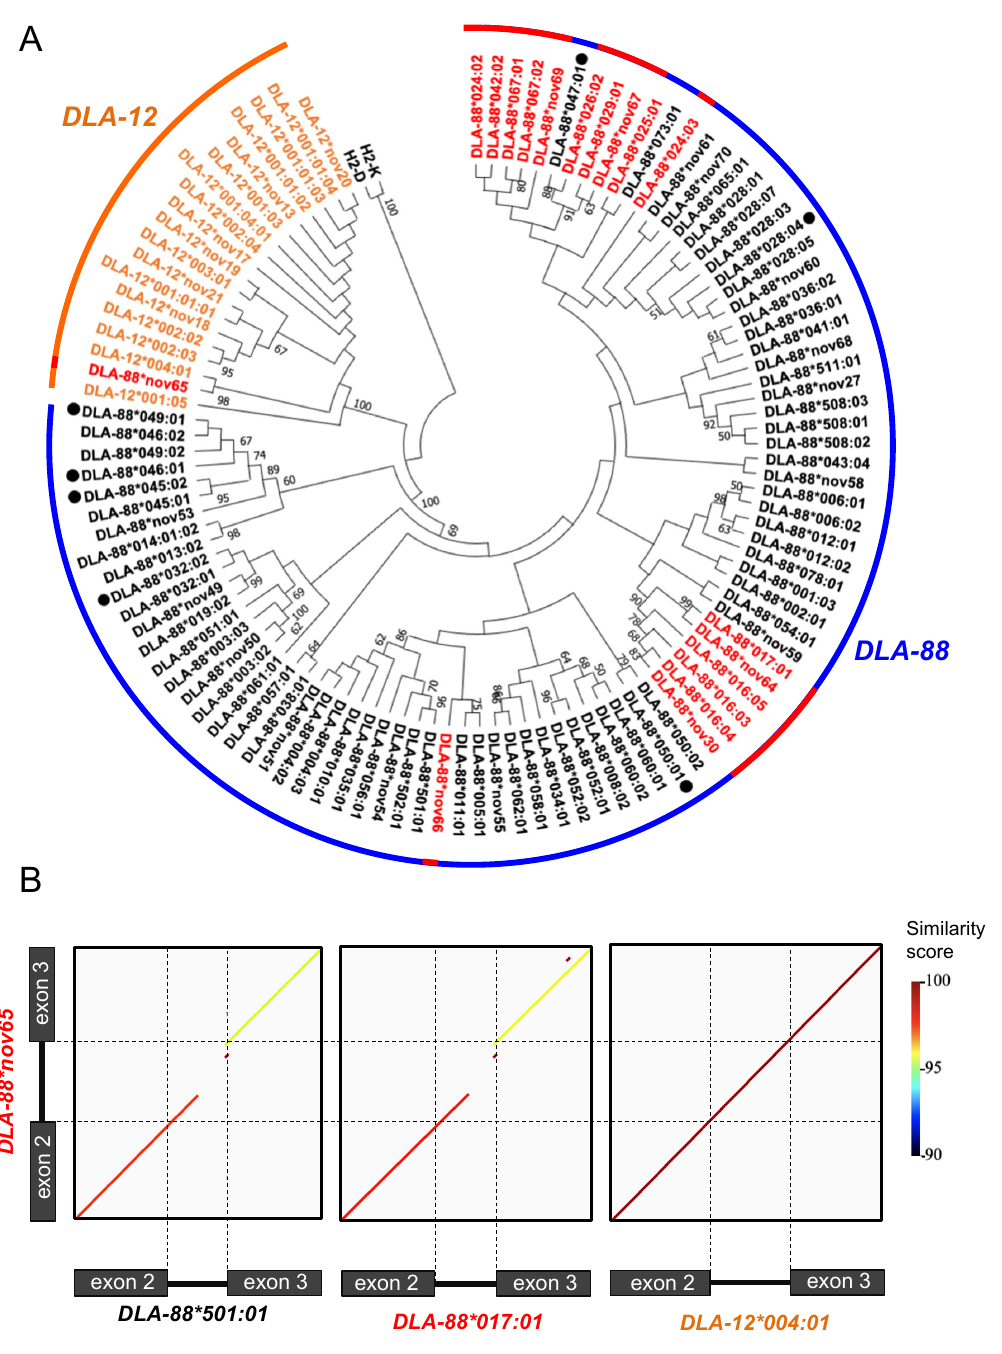
Figure 3. Phylogenetic relationship among the DLA-88 , DLA-12 , and DLA-88L allele sequences. ( A ) Neighbor-joining phylogenetic tree with exon 2–intron 2–exon 3 sequences of 109 alleles of DLA-88 , DLA-12 , and DLA-88L . The DLA-12 and DLA-88L alleles are represented with orange and red characters, respectively. Alleles that were not detected from 829 dogs in our study sample are indicated with a black-filled circle. Nucleotide sequences of H-2D and H-2K are used as an outgroup of the tree. ( B ) Dot-match analysis between two alleles by GenomeMatcher. The sequence similarity between DLA-88*nov65 and DLA-88*501:01 , DLA-88*017:01 or DLA-12*004:01 are displayed by lines. The lines are colored based on the similarity score calculated by the bl2seq program with parameter as follow: word size 10 and e-value threshold 0.1. When the similarity score was lower than 90, the line was not described at the region. Dashed lines indicate the boundary of exon and intron in each